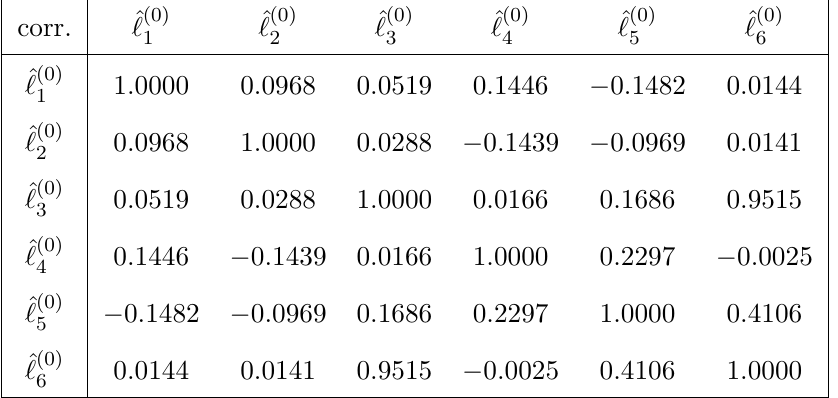
n o n o ^ ‘ ( n ) ^ ‘ ( n ) { in SM (2 = 1 = 1{6 1{6